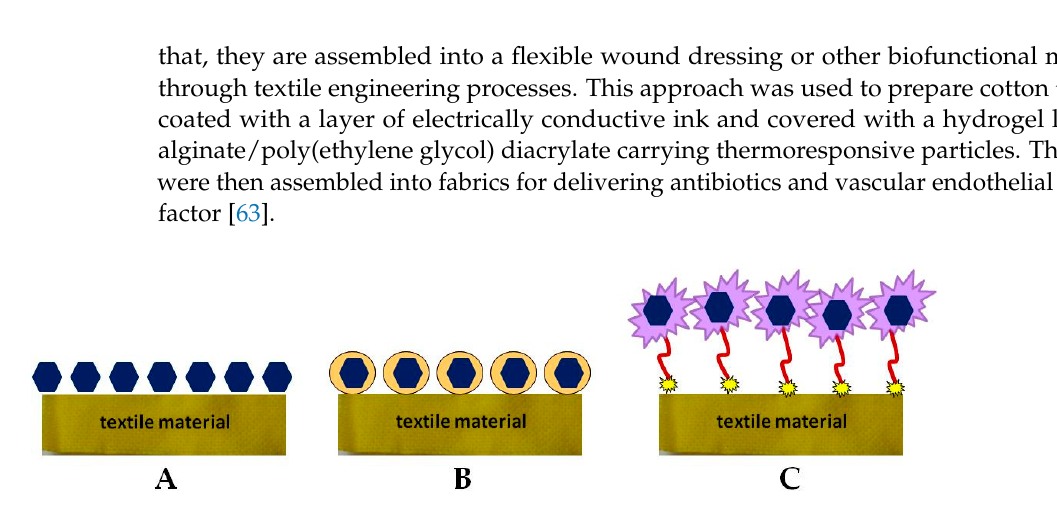
Figure 2. Methods for immobilizing bioactive compounds (BAS) onto a textile material: ( A ) direct immobilization; ( B ) encapsulation; ( C ) via a spaser.